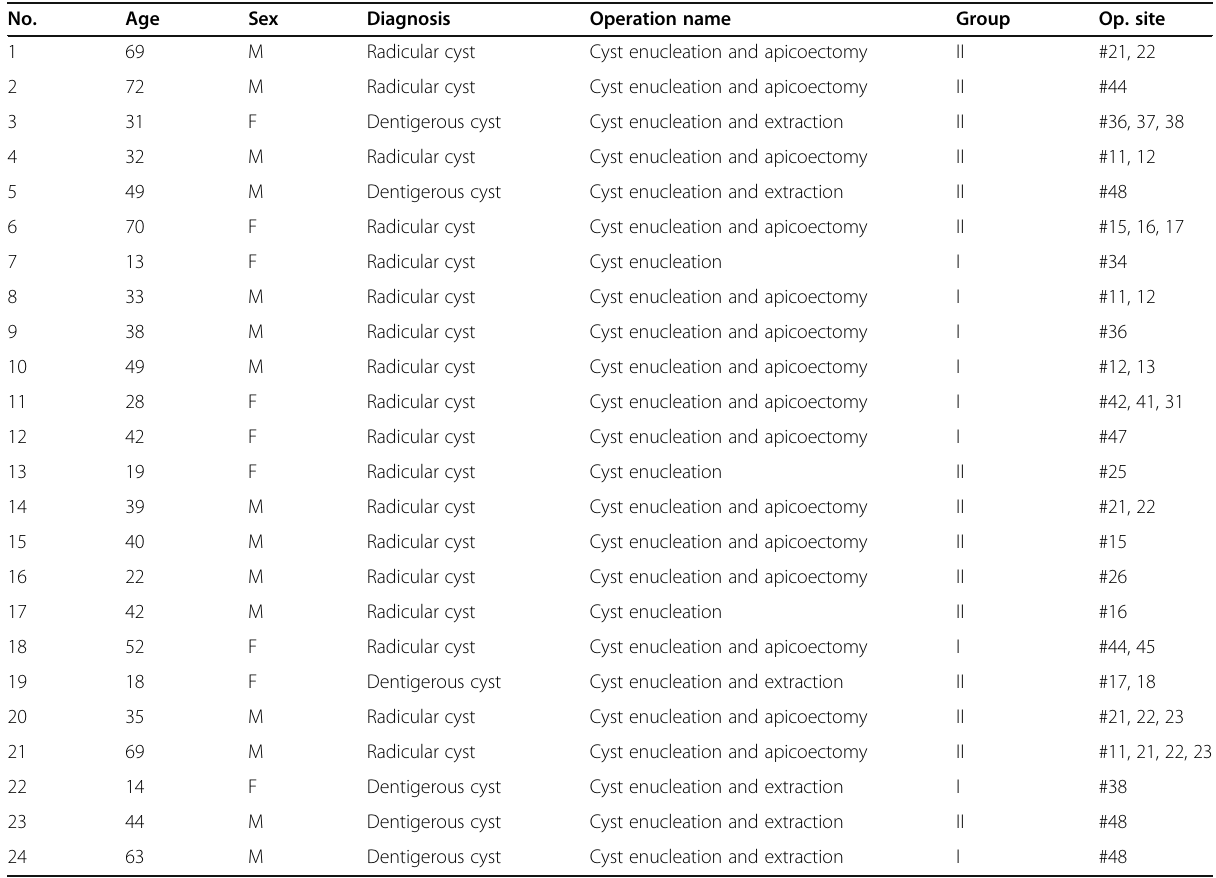
Table 1 Data included epidemiologic (gender, age, and date of surgery), clinical, and surgical information No.